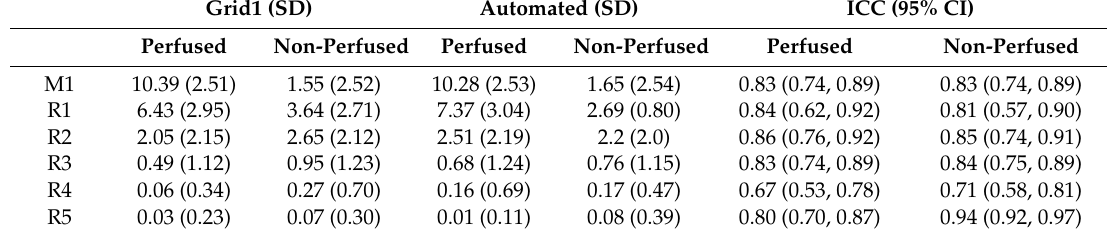
Table 2. Number of perfused and non-perfused segments in each ring and ICC values (SD: standard deviation, CI: confidence interval).